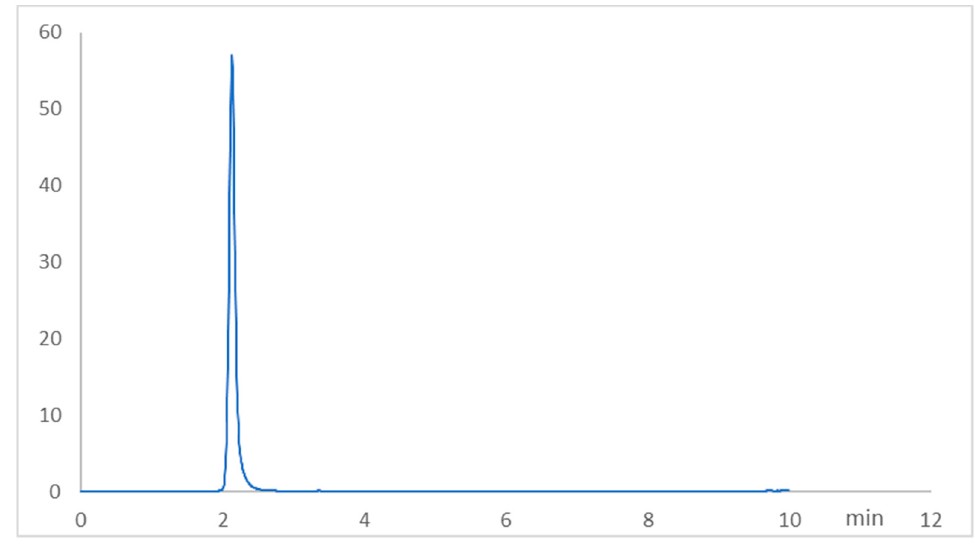
Figure 1. Representative RP-HPLC chromatogram of fasudil (2.12 min, 3.0 μ g/mL) under optimized conditions. Table 1. Summary of the HPLC method development.